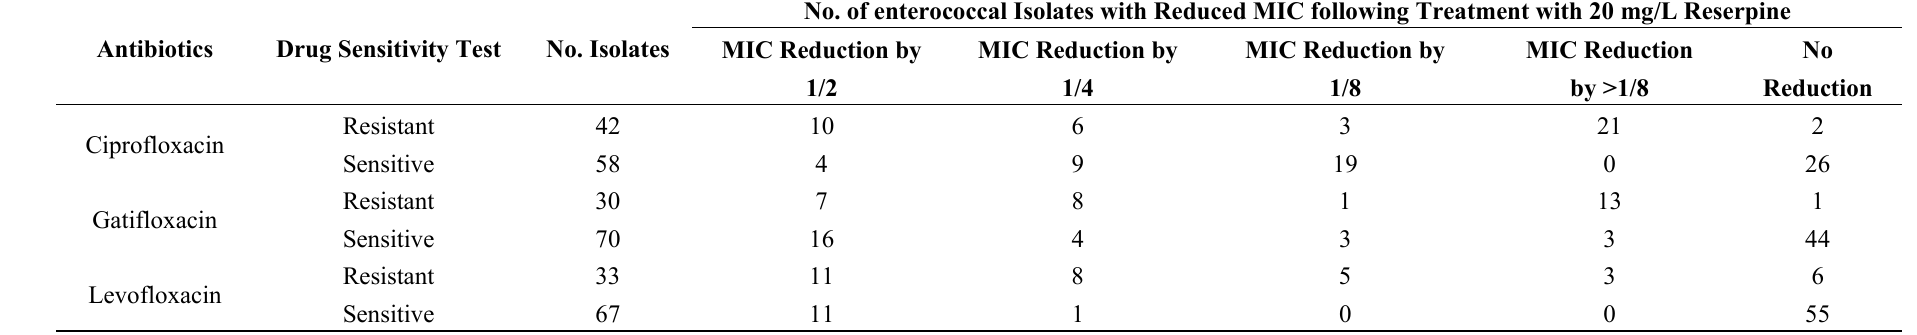
Table 7. Changes in MIC50 and MIC90 of three fluoroquinolones for 100 multiple-drug enterococcal strains before and after reserpine treatment. Time